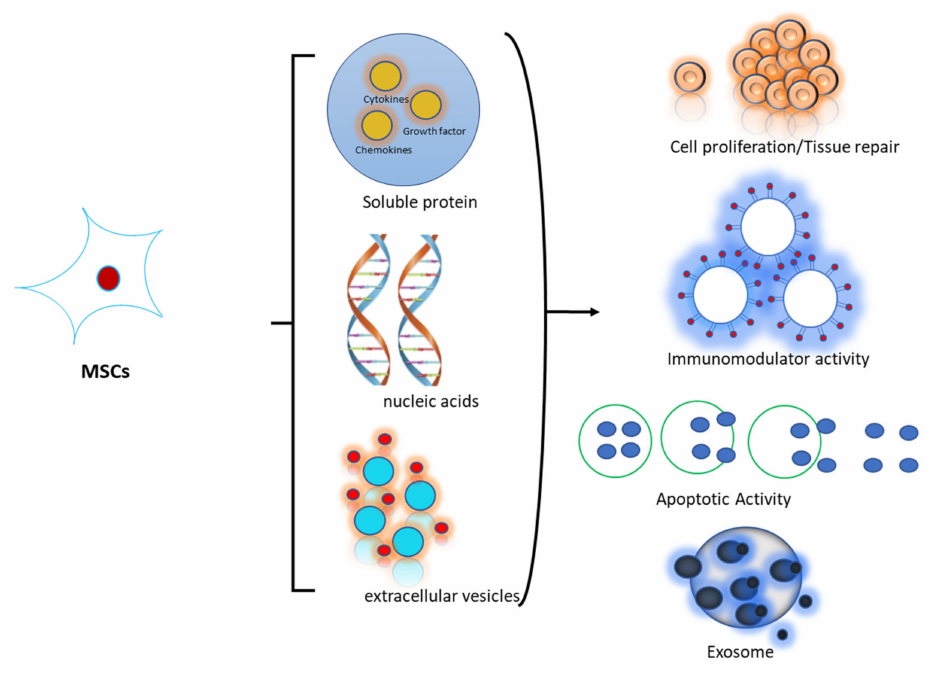
Figure 2. Scheme of the Mechanism of Action of